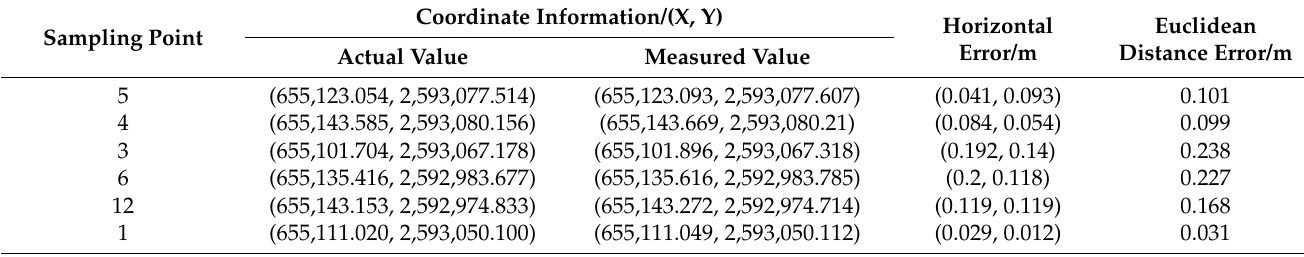
Table 5. UTM coordinate comparison of sampling